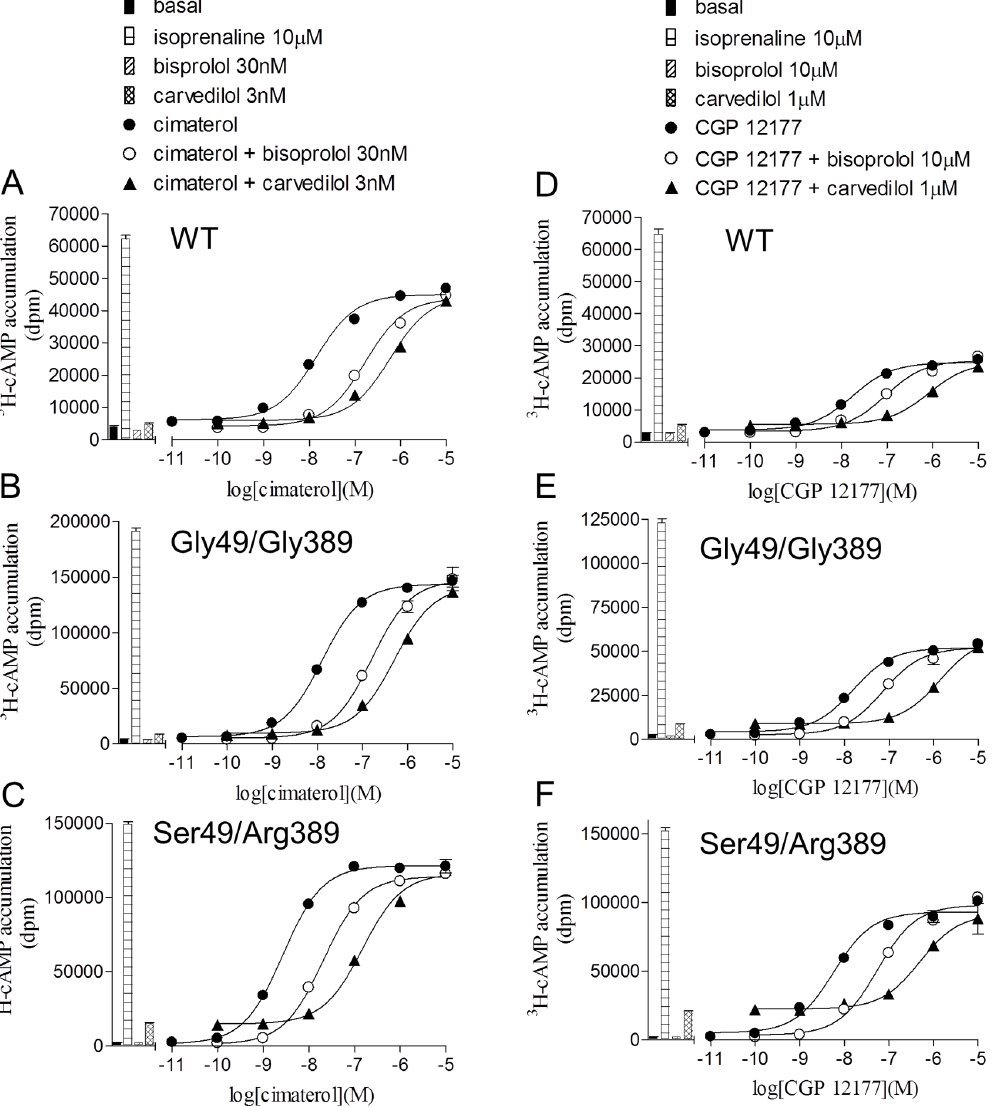
Figure 2. Inhibition of 3 H-cAMP accumulation responses to cimaterol and CGP 12177 at the wildtype and polymorphic variant receptors. 3 H-cAMP accumulation in response to cimaterol and CGP 12177 in A and D wildtype (WT) cells, B and E Gly49/Gly389 cells and C and F Ser49/Arg389 cells in the absence and presence of bisoprolol and carvedilol. Bars represent basal 3 H-cAMP accumulation, that in response to 10 m M isoprenaline and that in response to 30 nM bisoprolol or 3 nM carvedilol for A , B and C or 10 m M bisoprolol or 1 m M carvedilol for D , E and F . Data points are mean 6 s.e.mean of triplicate determinations and these single experiments are representative of 4 separate experiments in each case. This demonstrates the difference in the affinity of antagonists for the catecholamine (high affinity) conformation and secondary (low affinity) conformation of the receptors and that both of these conformations exist in all receptor variants.